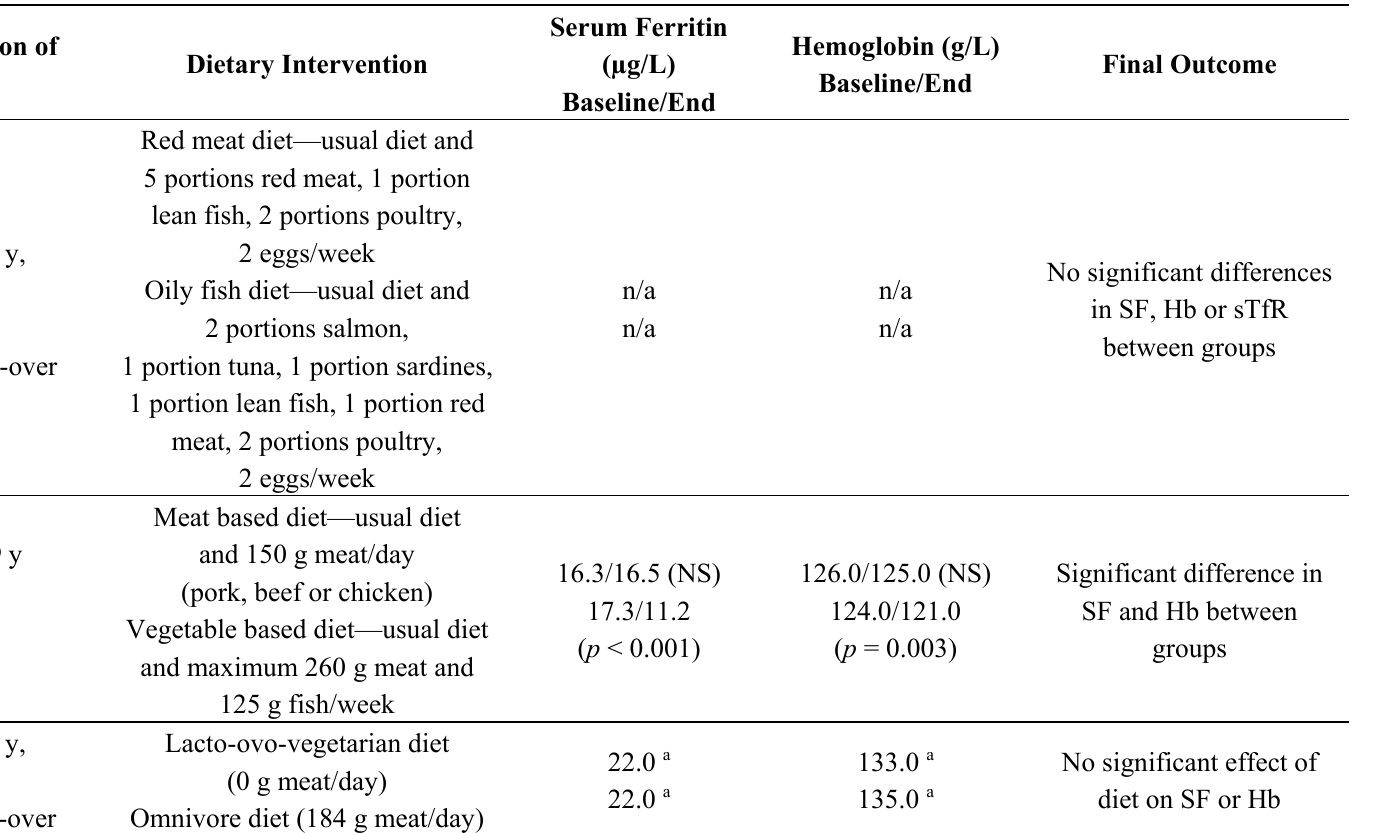
Table 4. Interventions using meat to improve to improve iron status in young